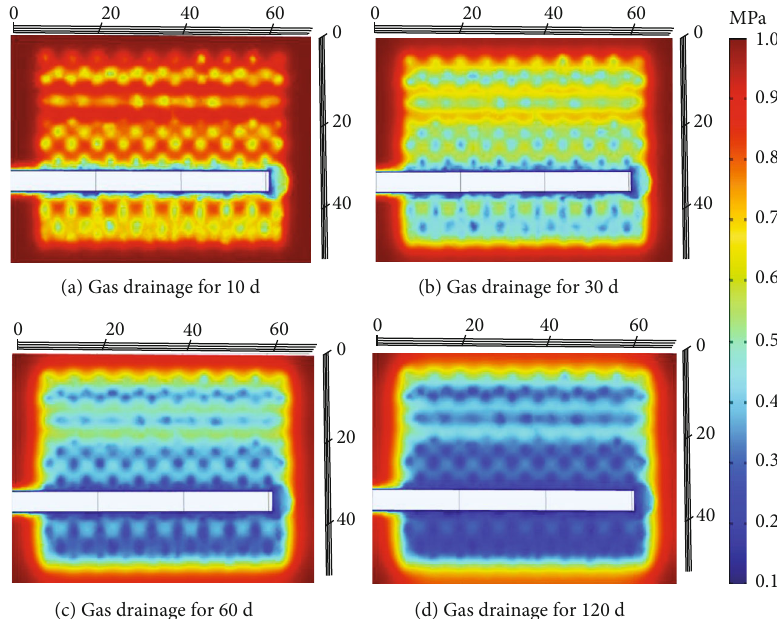
Figure 8: Gas pressure distribution when roadway drives 60 m with di ff erent extraction times. Table 2: Measured results of gas pressure and gas